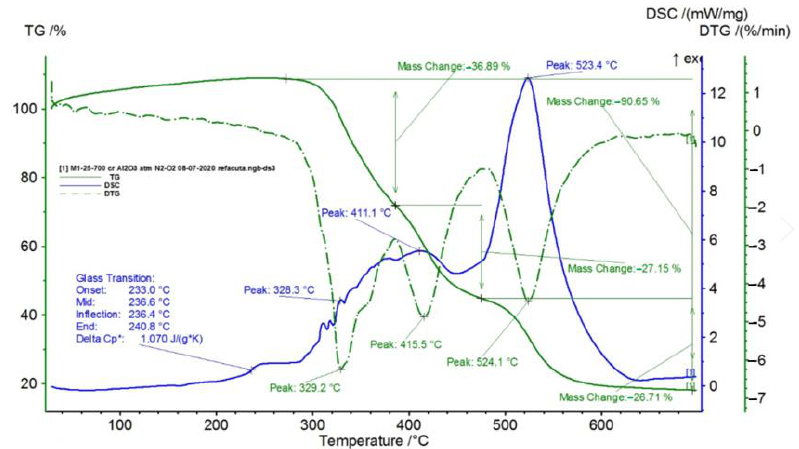
Figure 4. TG/DSC curves registered for BaTiO 3.